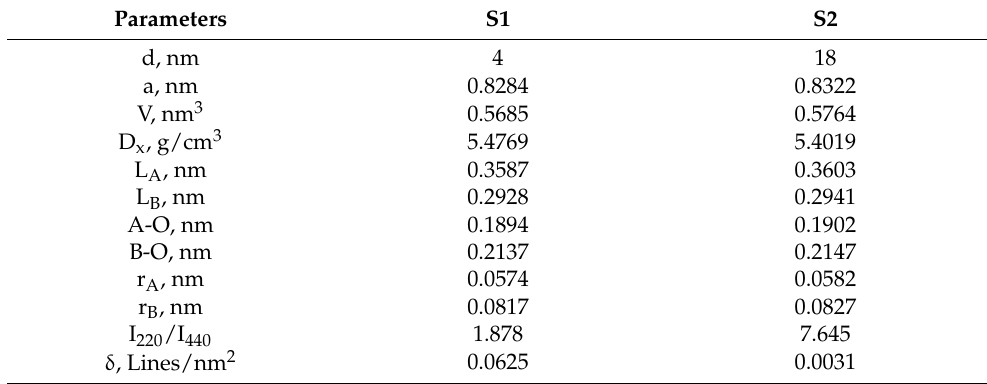
Table 1 . Lattice parameters of NiFe 2 O 4 nanoparticles. Table 1. Lattice parameters of NiFe 2 O 4 nanoparticles.